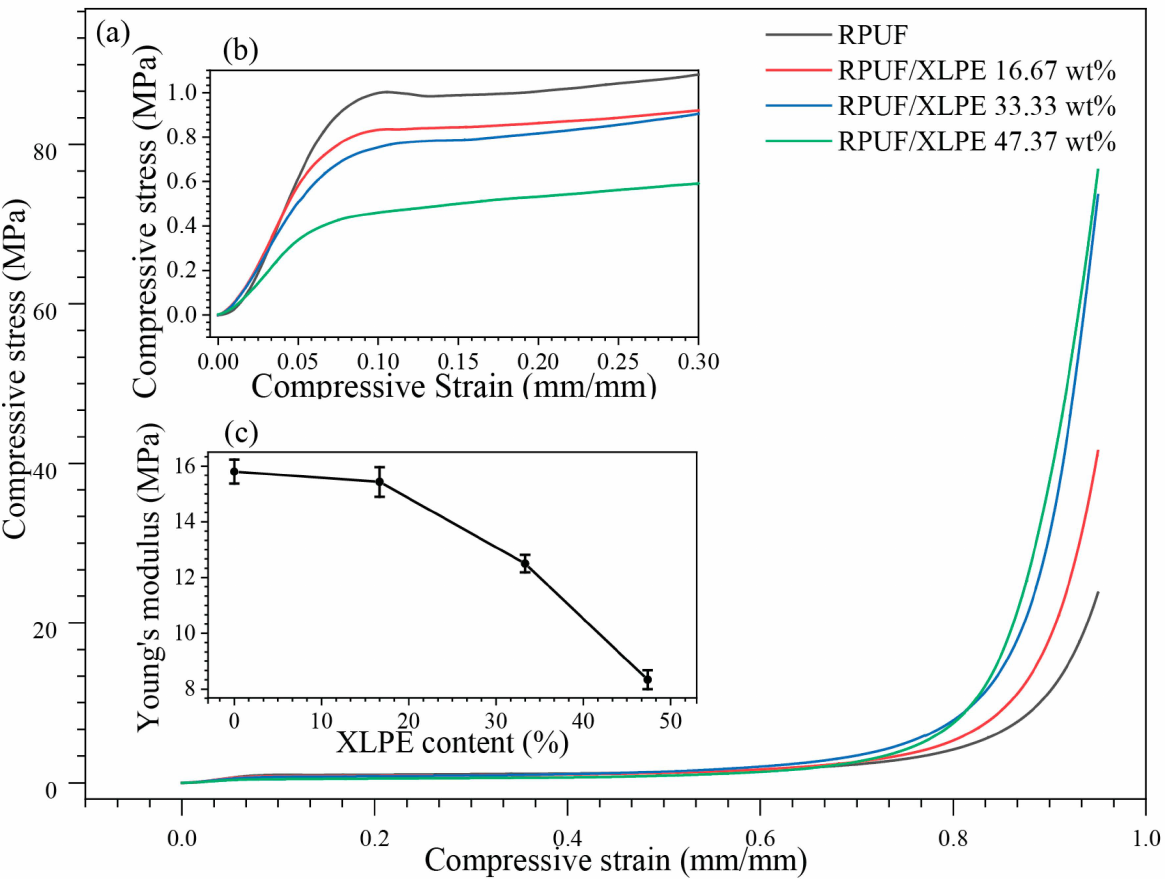
Figure 6. ( a ) Compression tests following the standard ASTM D1621-16 (i.e., Standard Test Method for Compressive Properties of Rigid Cellular Plastics), with the ( b ) zoomed-in elastic regions and ( c ) Young’s modulus as a function of the XLPE